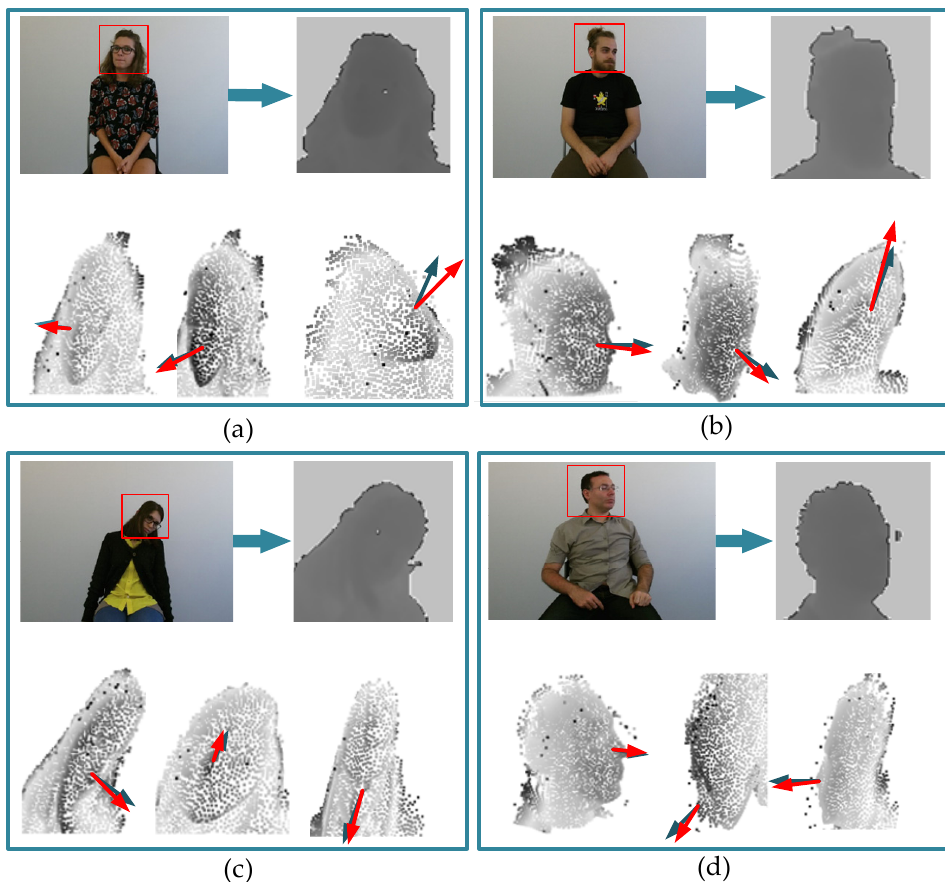
Figure 10. Examples on the Pandora dataset. ( a – d ) are different objects with variable head poses. The first rows show the RGB images and the corresponding depth maps of head regions. The second rows show the point clouds of the objects and the pose prediction results, where the red arrows are the ground truth, and the dark blue arrows are the prediction values.